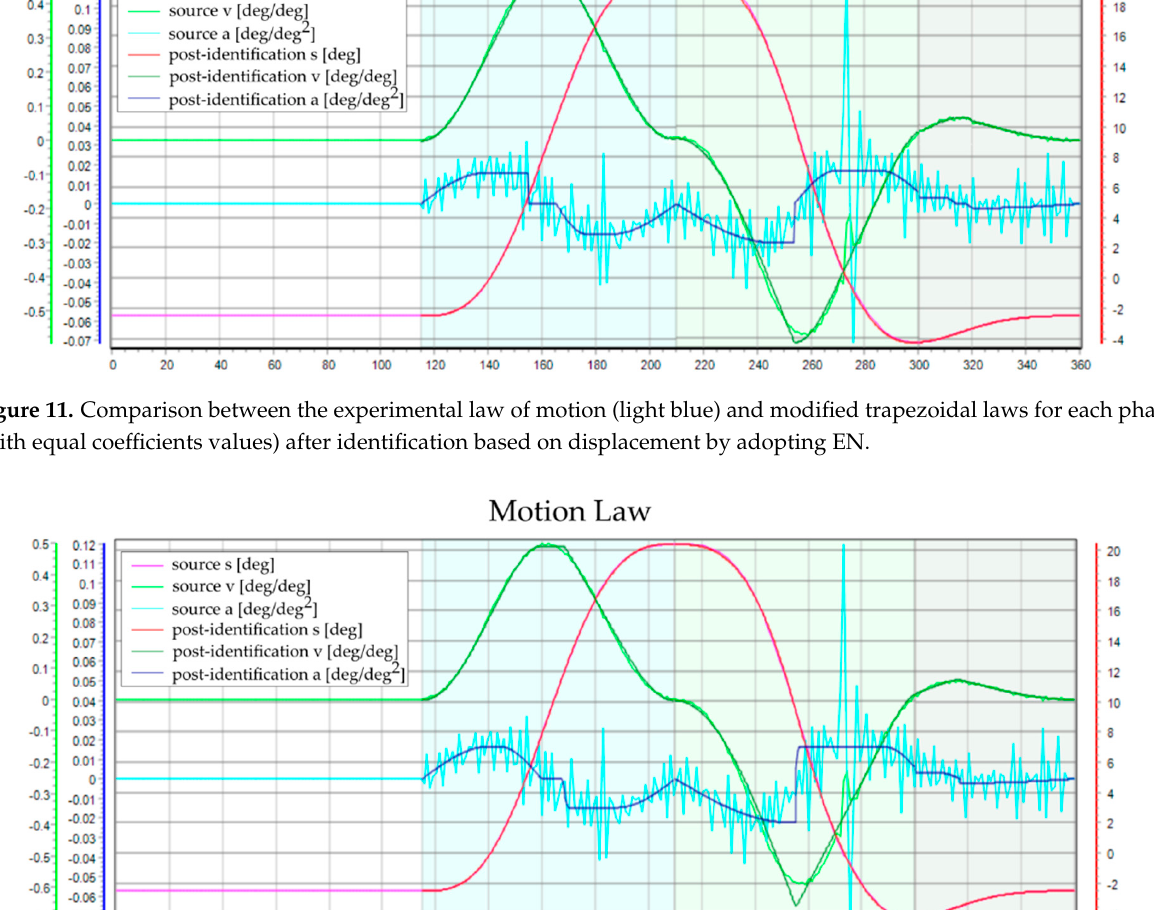
Figure 12. Comparison between the experimental law of motion (light blue) and modified trapezoidal laws for each phase (with equal coefficients values) after identification based on displacement by adopting the DTW algorithm.